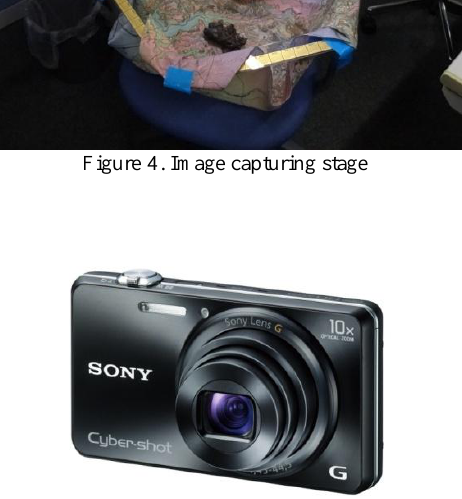
Figure 5. SONY Cyber-shot DSC-WX200 Table 1. Two set of images Image Set A